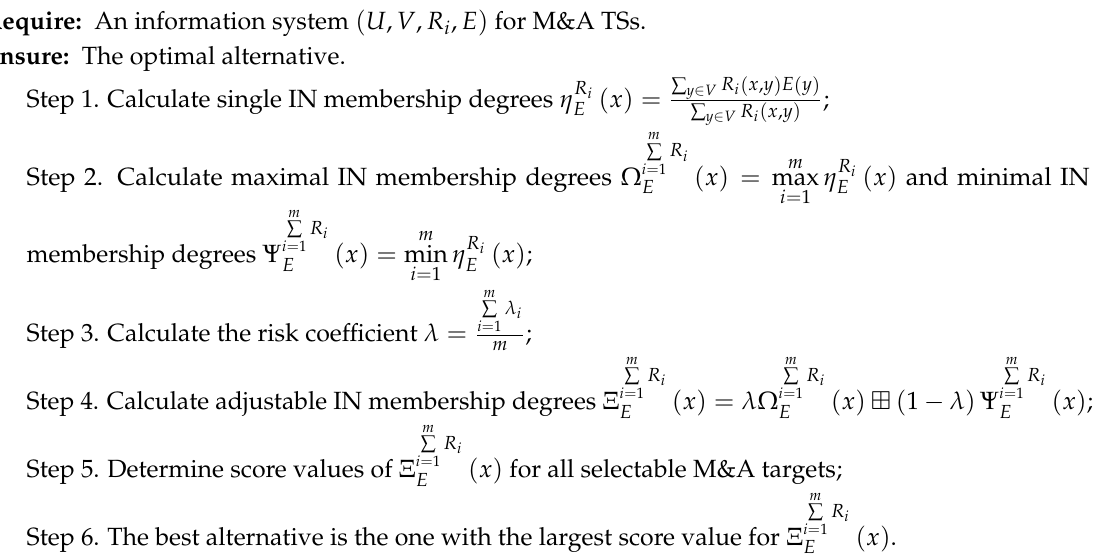
Algorithm 1 An algorithm for M&A TSs in light of adjustable IN MG-PRSs over two universes. Require: An information system ( U , V , R i , E ) for M&A TSs. Ensure: The optimal